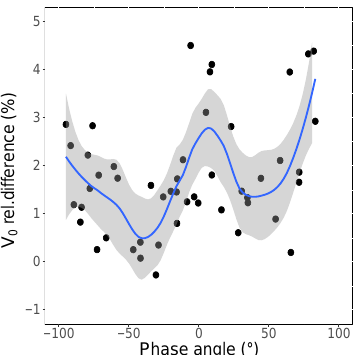
Figure 2. Calibration coefficients ( V 0 ) relative difference (%) at 870nm when Langley and lunar Langley absolute calibration tech- niques are compared. Smoothing by means of LOESS (locally esti- mated scatterplot smoothing) is shown with solid line. The shaded areas represent the 95% confidence